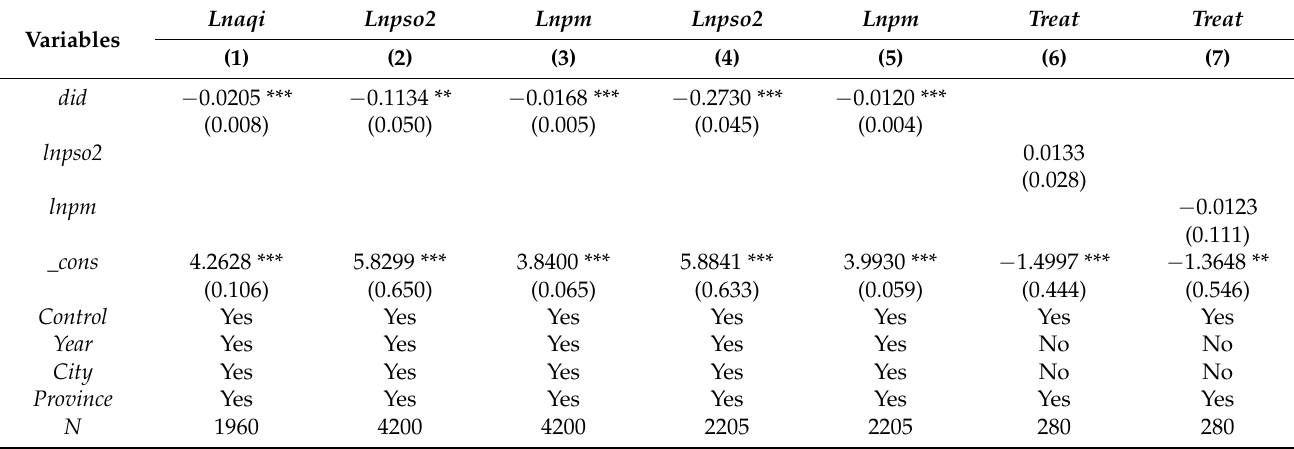
Table 6. Other robustness